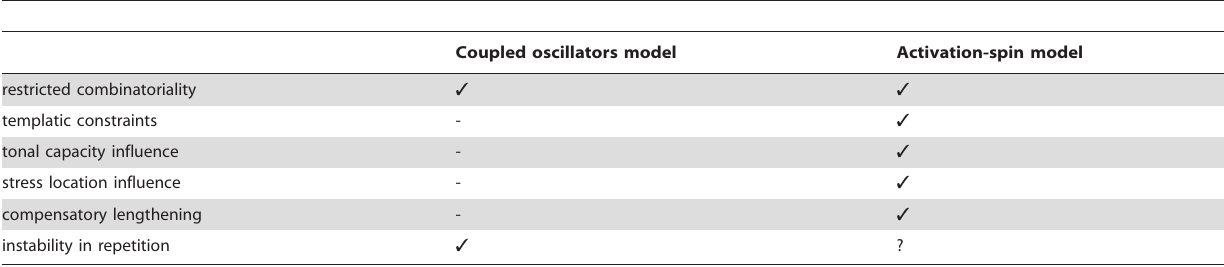
Table 1. Comparison of the standard coupled oscillators model and the activation-spin model in accounting for onset/coda